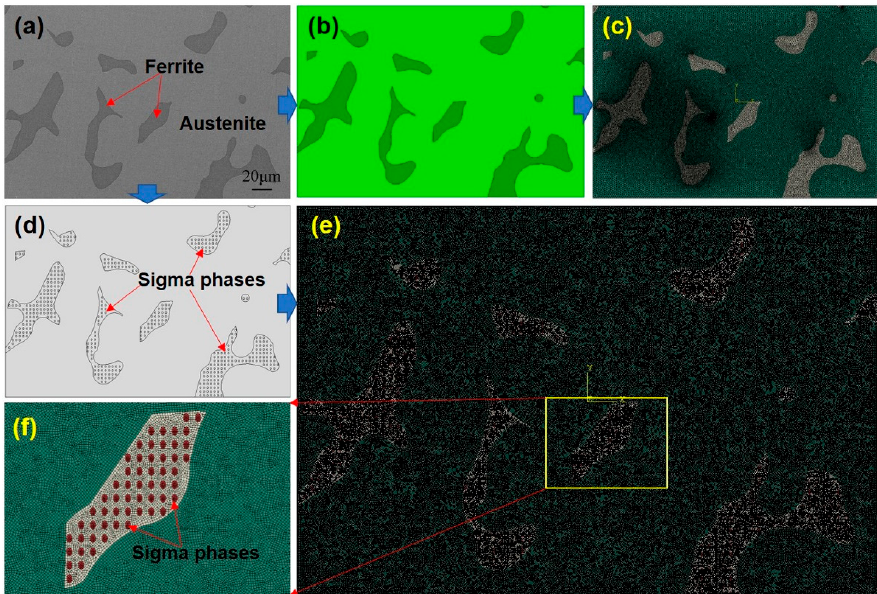
Figure 3. Geometry and size of specimens used for moderate-temperature tensile tests at 350 °C.